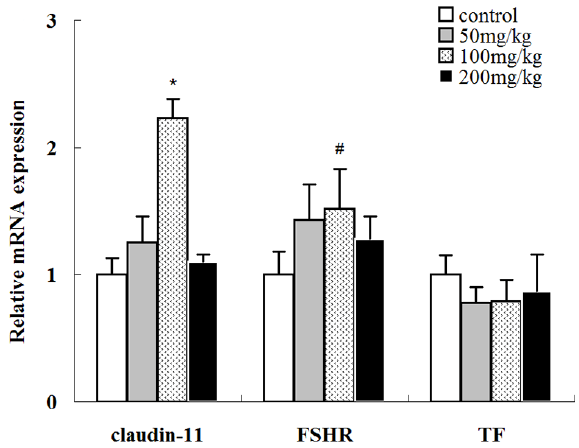
Figure 7. Expressions of claudin-11, FSHR, and TF mRNA in the testes of rats treated with different doses of icariin. The mRNA levels were normalized to β -actin mRNA. The mRNA levels of the control group were set as 1. Values are the mean ± SD of 10